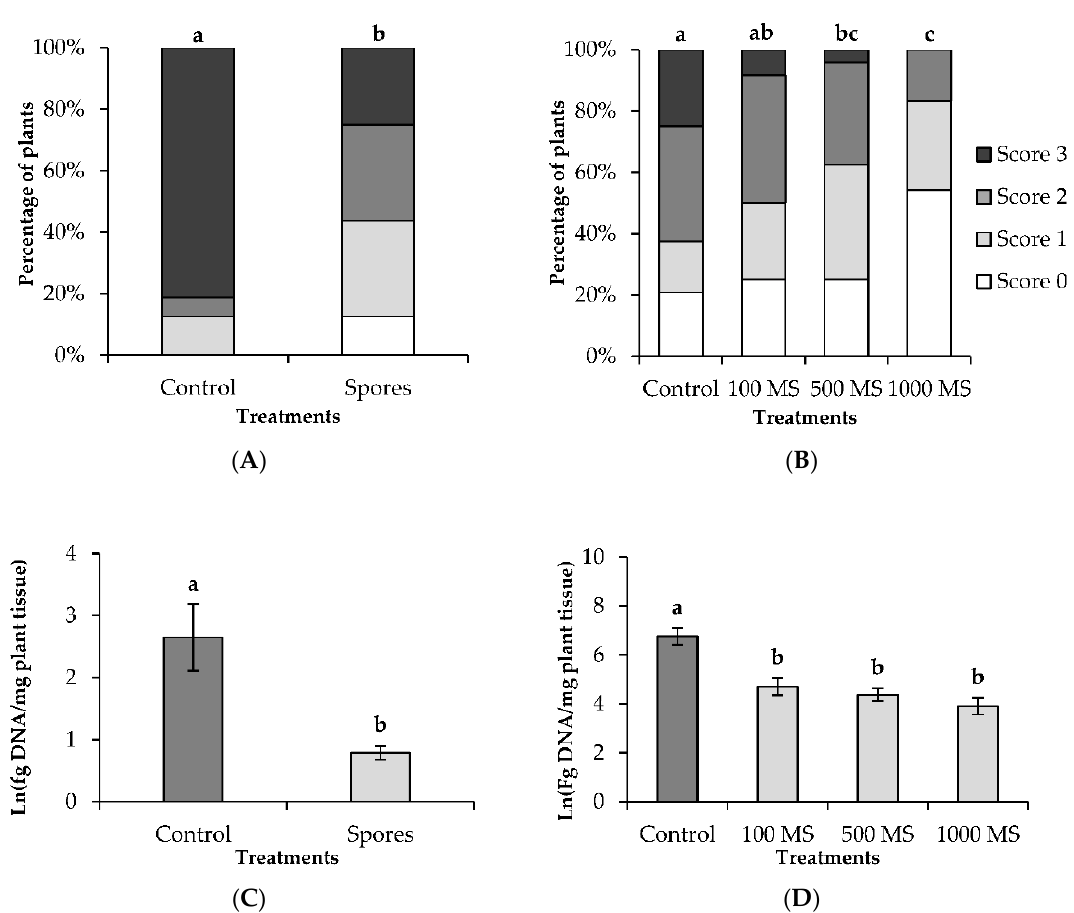
Figure 1. Biocontrol of Verticillium wilt in cauliflower in greenhouse conditions when V. isaacii Vt305 was applied as spores or as microsclerotia (MS). ( A ) Vascular discoloration 70 days post transplantation (dpt) to naturally infested soil of cauliflower plants inoculated with V. isaacii Vt305 via root dip in a spore suspension with a concentration of 10 6 spores mL − 1 or mock-inoculated via root dip in sterile water in case of the control; ( B ) Vascular discoloration 103 dpt to naturally infested soil of cauliflower plants inoculated with V. isaacii Vt305 via seed treatment with a microsclerotia suspension applied in di ff erent concentrations (100, 500, or 1000 microsclerotia plant − 1 ) or mock-inoculated via seed treatment with sterile water in case of the control. Results on vascular discoloration are shown as percentage of plants ( n = 12) with a specific score for vascular discoloration: 0 = no vascular discoloration; 1 = vascular discoloration of < 50% of stem length; 2 = vascular discoloration of 50–75% of stem length; and 3 = vascular discoloration of 76–100% of stem length. ( C ) Amount of detected V. longisporum DNA in the hypocotyl 28 dpt when V. isaacii Vt305 was applied as spores; ( D ) Amount of detected V. longisporum DNA in the hypocotyl 103 dpt when V. isaacii Vt305 was applied as microsclerotia. Values are means ± standard error ( n = 6). Colonization data were ln transformed before statistics. Bars indicated with the same letter are not significantly di ff erent according to a Mann–Whitney U-test in case of the vascular discoloration and according to a Tukey test in case of the colonization data ( p < 0.05).